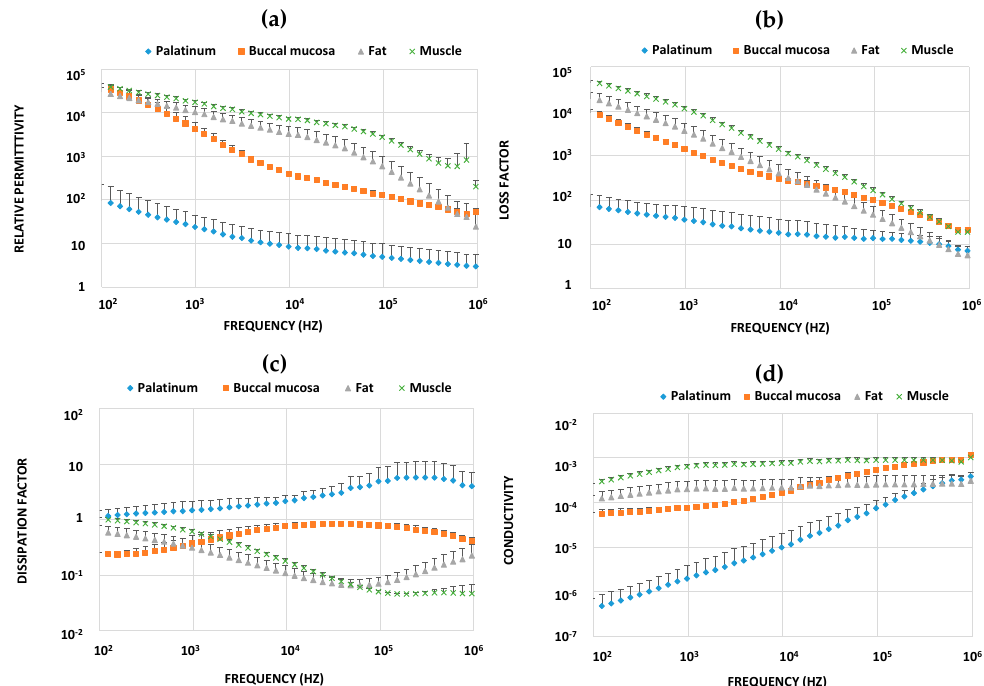
Figure 7. Relative permittivity ( a ), loss factor ( b ), dissipation factor ( c ), and conductivity ( d ) determined for different ex vivo pork oral tissue samples on the basis of BIS measurements using the inner configuration. Data represent mean values and error bars indicate the standard deviation of the mean in one direction.